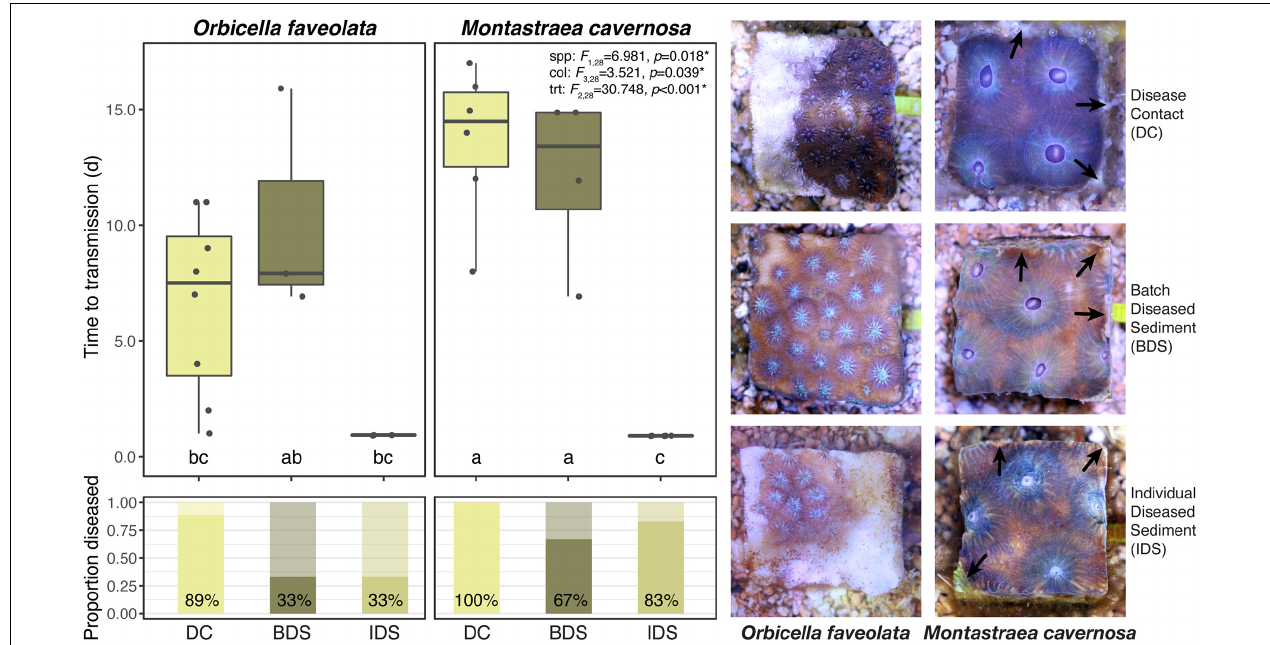
FIGURE 2 | Mean time to transmission (initial observation of lesions) and transmission rates (proportion diseased) by species and disease treatments, with representative photographs. Error bars denote standard error of the mean, test statistics indicate the results of three-way ANOVA among species, colonies, and treatments, and different letters denote significant pairwise differences as generated by Tukey’s test. Healthy sediment treatment not shown or analyzed due to no observed cases of transmission in the treatment. Treatment abbreviations as in Table 1 , and treatment colors as in Figure 1 . Arrows in photo panel indicate excess mucus production (Top right) , tissue necrosis (Center right) , and tissue retraction (Bottom right) observed more commonly in M. cavernosa fragments.